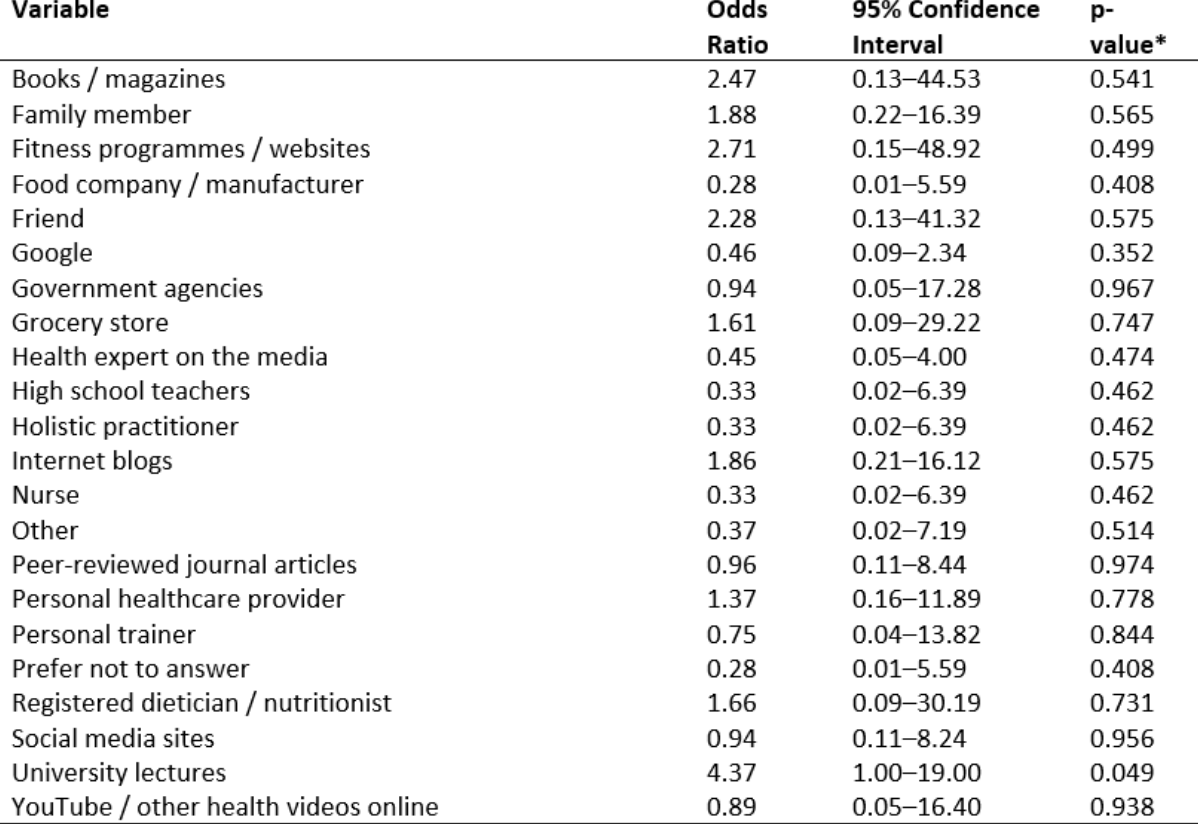
Table 2. Univariate analyses results of primary nutrition information sources influencing first year Canadian and US veterinary students’ self -reported perceived amount of information to exist on human nutrition showing variables, odds ratio, 95% confidence intervals, and significance values